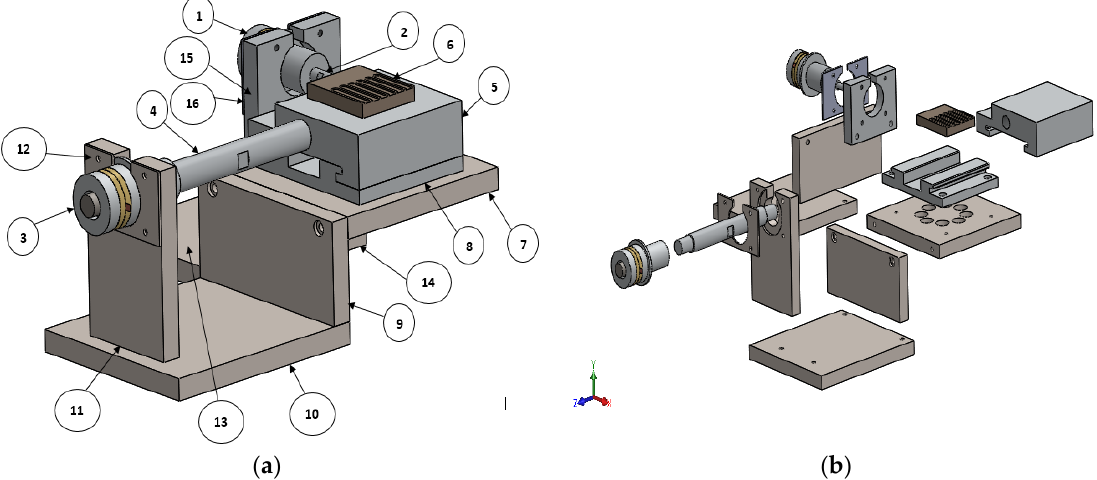
Figure 1. Proposed 2D vibratory device; ( a ) Assembled model: (1) piezoelectric Langevin transducer for the vibration in the feed direction “T1”, (2) short threaded horn, (3) piezoelectric transducer for the vibration in the thrust direction “T2”, (4) long threaded horn, (5) slider table, (6) workpiece, (7) base plate, (8) linear guideways, (9,10) L-shape stand for “T2”, (11) robust stand for “T2”, (12) cover plate for “T2”fixation, (13,14) L-shape stand for “T1”, (15) small robust stand for “T1”, (16) cover plate for “T1”fixation; and ( b ) Exploded model.